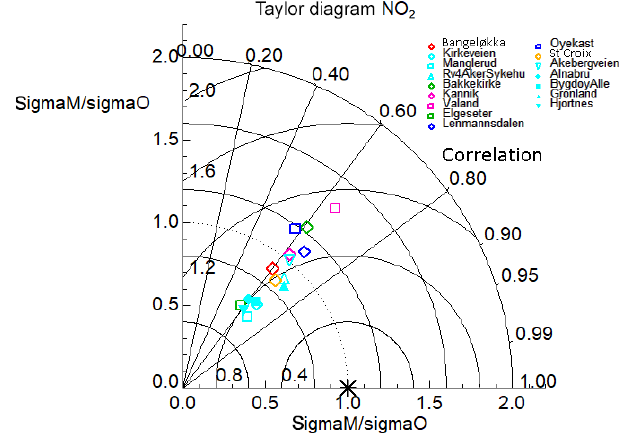
Figure 10. A Taylor diagram calculated using the summer-only (June, July, and August) hourly time series of NO 2 concentrations for 13 in situ stations used for the model evaluation across five out of the six domains (excluding Stavanger). The symbols are colour- coded according to each model domain: Drammen is red, Oslo is cyan, Trondheim is green, Stavanger is pink, Grenland is dark blue, and Nedre Glomma is orange. The x and y axes both represent the ratio of the model standard deviation to the observed standard devi- ation in NO 2 concentrations for a particular station such that points can be plotted on concentric circles centred on the x/y origin. The correlation is plotted according to the azimuthal angle from the ori- gin represented as a series of straight lines emanating from the x/y origin. Lastly, the RMSE (µgm − 3 ) is also represented for each sta- tion according to their linear distance from 1.0 on the x